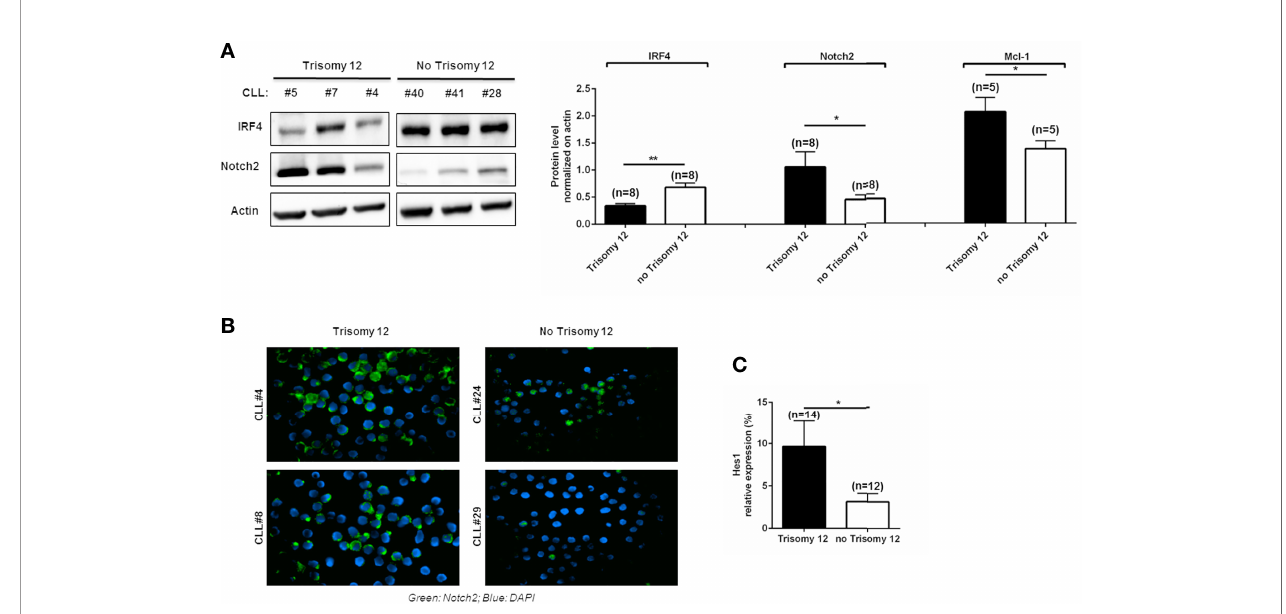
FIGURE 1 | Trisomy 12 chronic lymphocytic leukemia (CLL) cells show low levels of IRF4 with higher expression of Notch2 and Mcl-1. (A) IRF4, Notch2, and Mcl-1 expression was measured by Western blot in CLL patients harboring trisomy 12 and with no trisomy 12. Blots represent three representative CLL patients harboring +12 and three without +12. On the right, bar diagrams represent the densitometric quanti fi cation of CLL samples with trisomy 12 and without trisomy 12 (*p < 0.05, **p < 0.01). (B) Immunostaining shows the expression of Notch2 in green and 4',6-diamidino-2-phenylindole (DAPI) in blue in two +12 and two no +12 CLL samples. (C) Hes1 expression was quanti fi ed in trisomy 12 vs. no trisomy 12 by real-time PCR (*p <